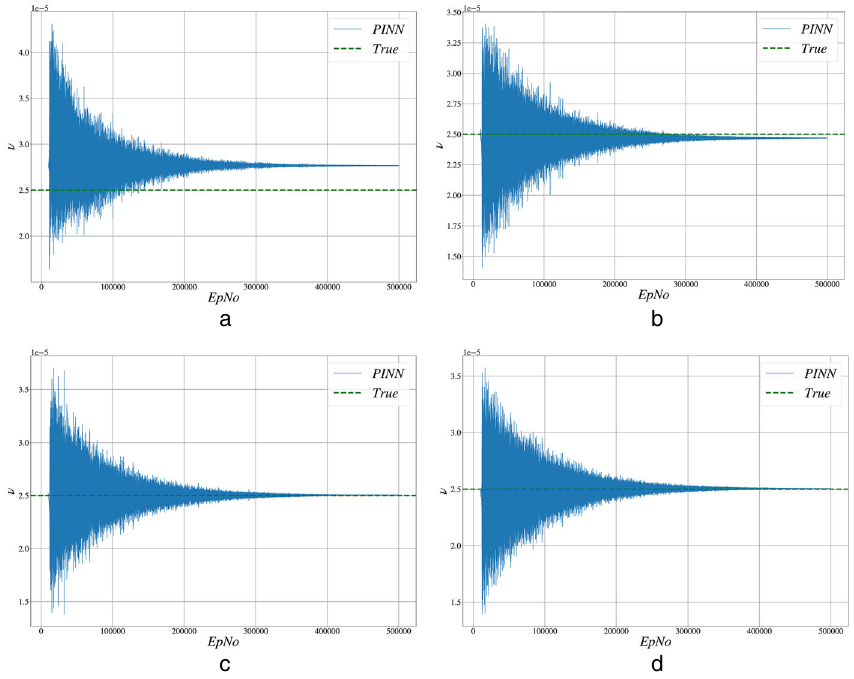
Fig. 13 The approximation of the physical viscosity by the PINN at each training epoch for different reduced number of modes. (a) Reduced setting : N u = N p = N S = 10. (b) Reduced setting : N u = N p = N S = 30. (c) Reduced setting : N u = N p = N S = 40. (d) Reduced setting : N u = N p = N S =